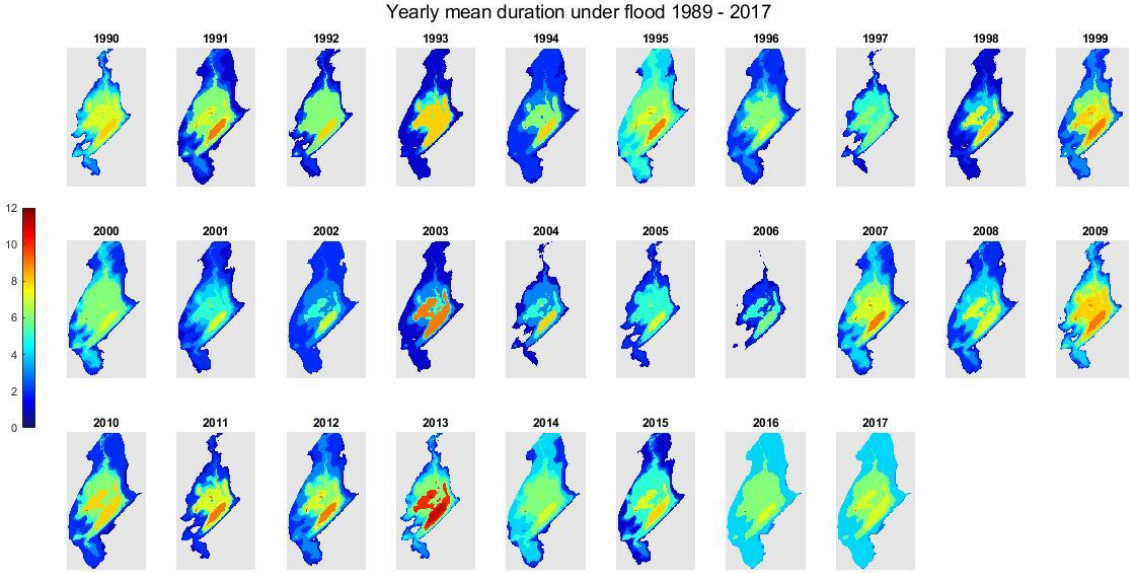
Figure 7. Annual flood duration spatial profiles for Blackrock turlough over a 28-year period (Bhatnagar et al., 2021).